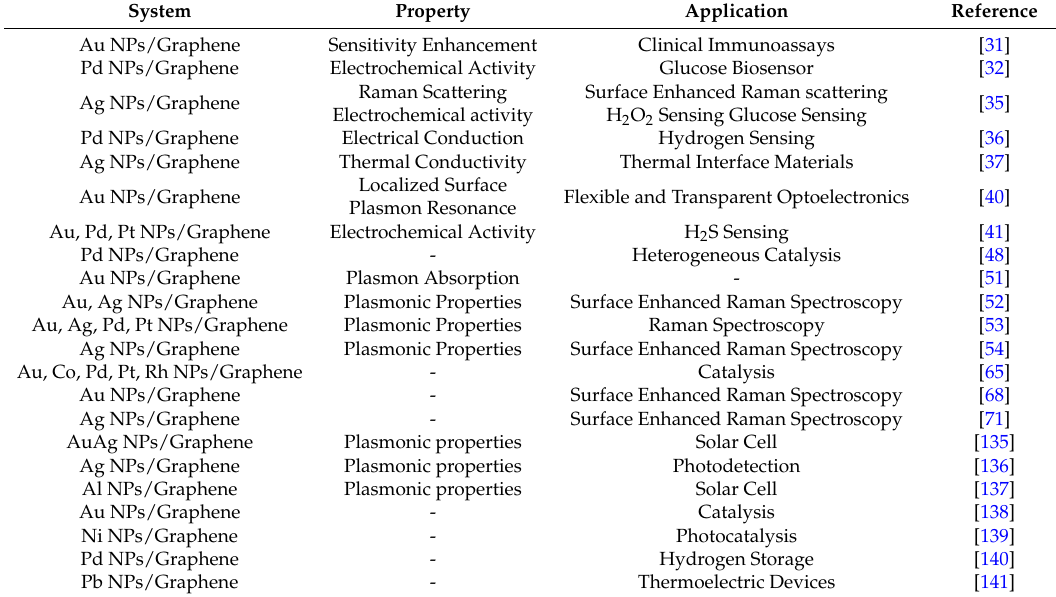
Table 5. Table summarizing some specific metal NPs-graphene composite systems with the corresponding exploited properties and/or